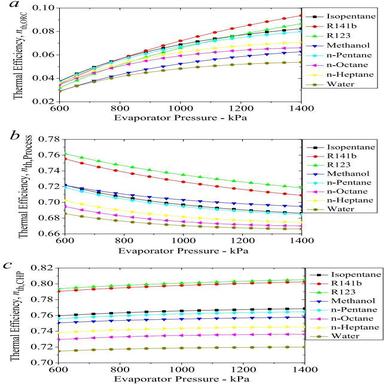
Thermal efficiencies as a function of evaporator pressure ORC (a) Process (b) CHP (c).